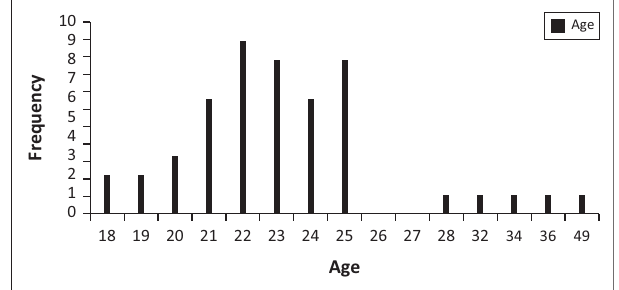
FIGURE 1: Study participants by age ( n =